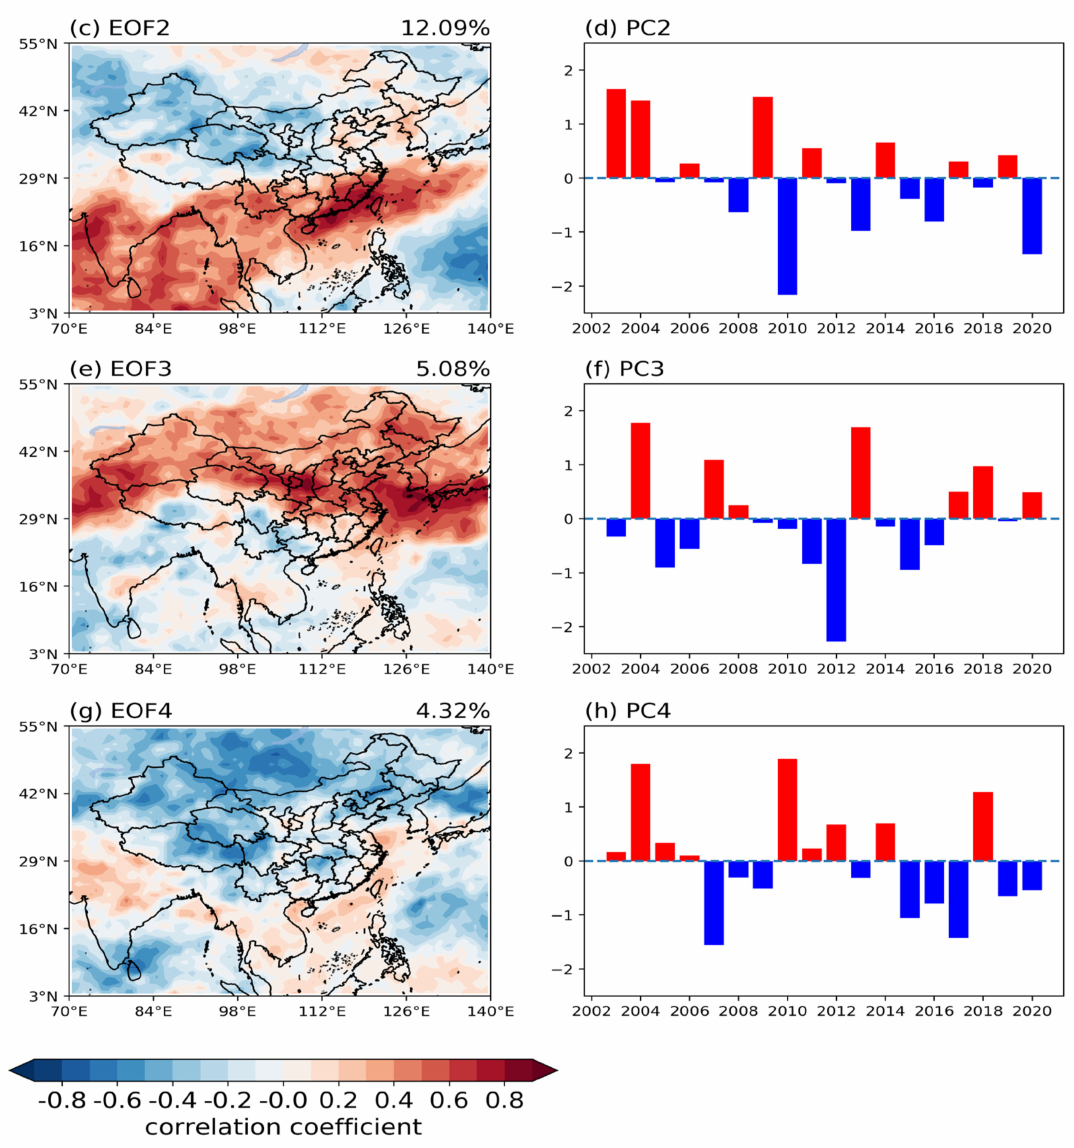
Figure 7. Empirical orthogonal decomposition of spatiotemporal features in China. ( a , c , e , g ) Four modes. ( b , d , f , h ) Four PC